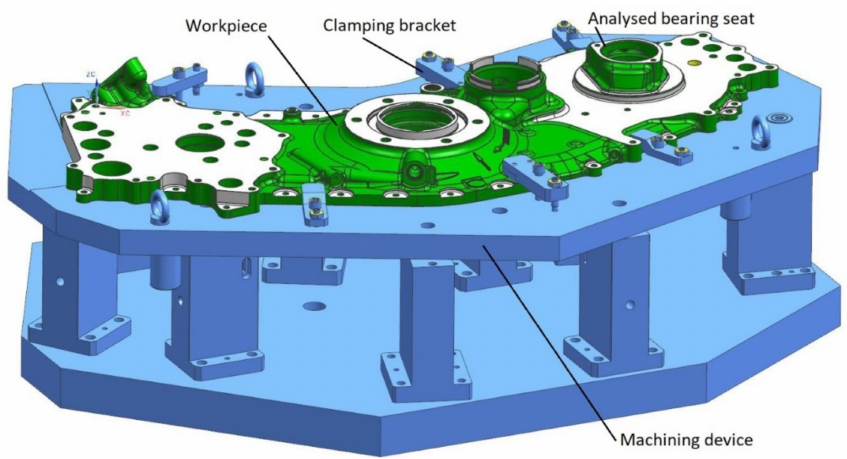
Figure 4. Accessory drive train (ADT) cover mounted in the machining device.